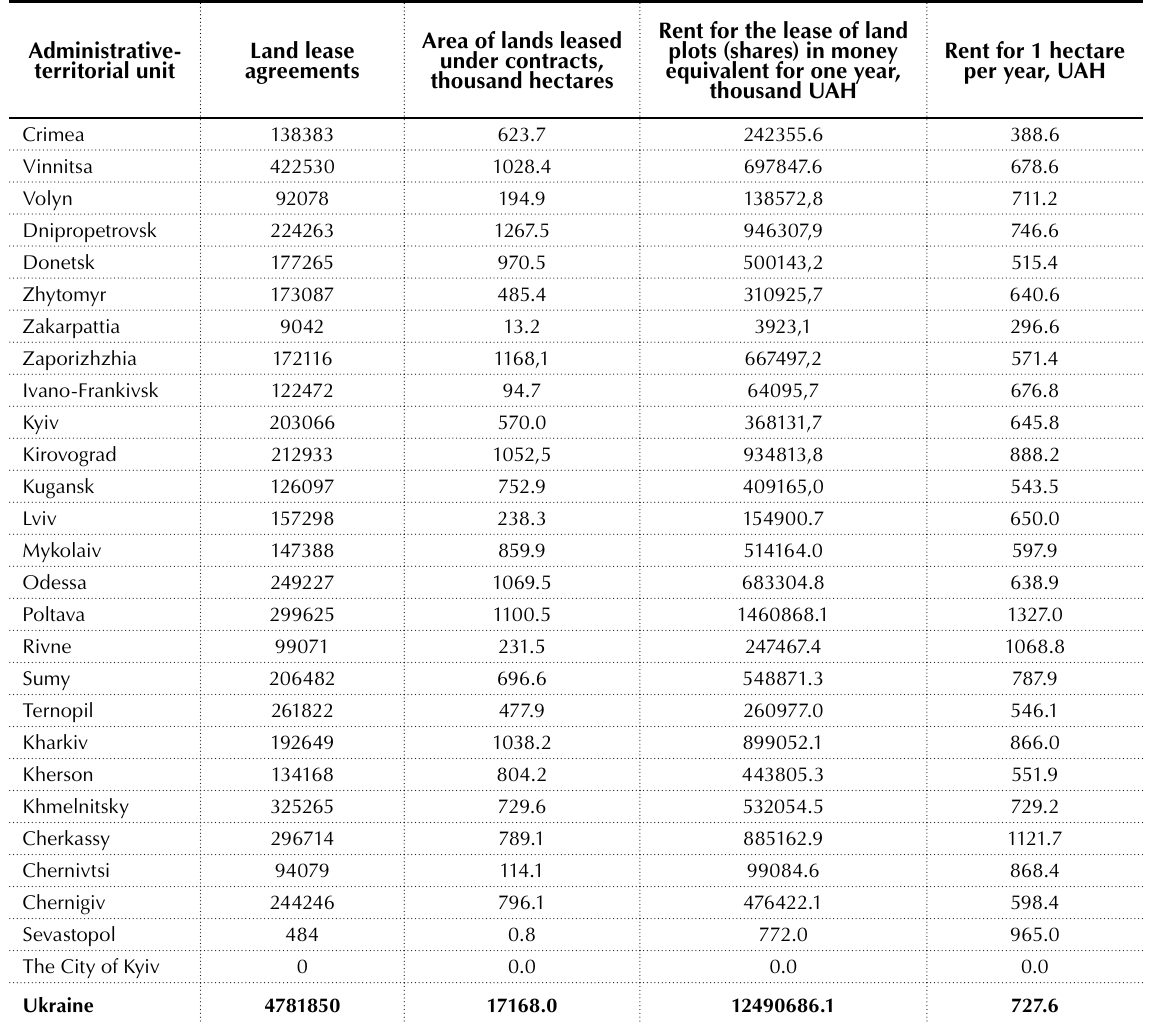
Table 2. The average rent size in Ukraine as of 01.01.2015 (Derzhgeokadastr ) Administrative- territorial